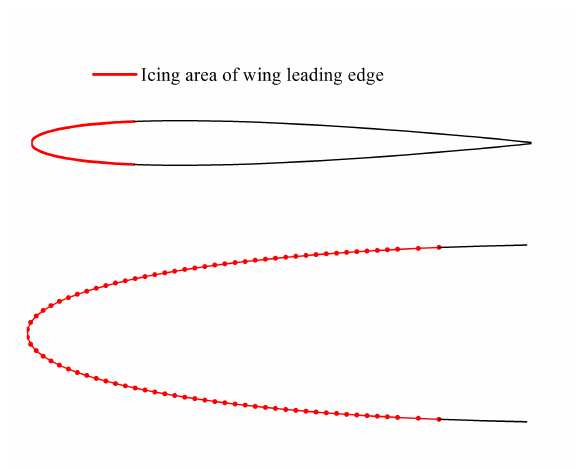
Figure 5. Wing leading edge icing and its node